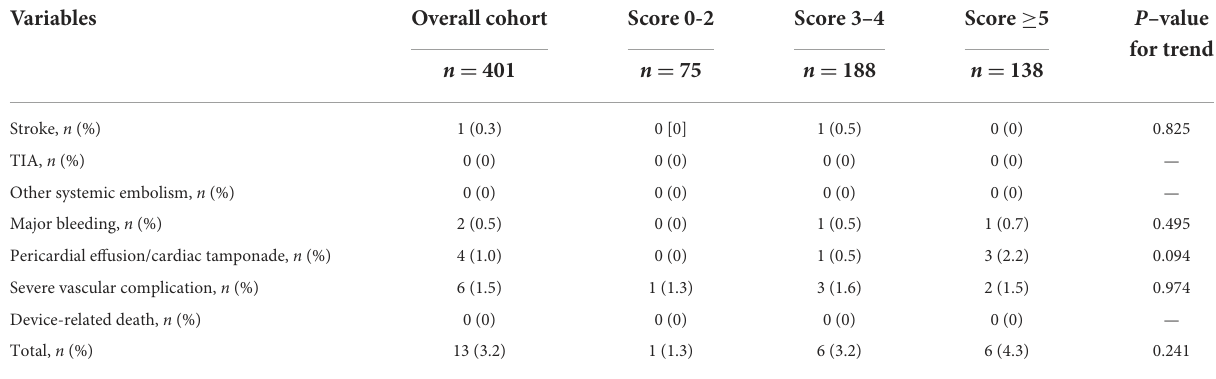
TABLE 2 Periprocedural complications within 7 days.